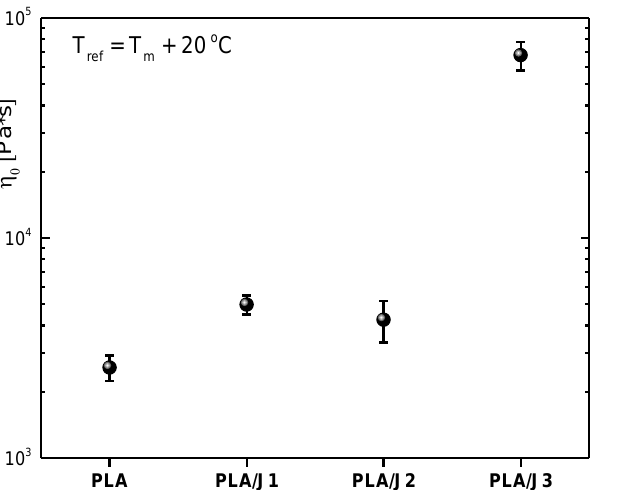
Figure 1. Zero shear (complex) viscosity for all the samples calculated at the same temperature distance from the T m , as derived from the fitting of the data with the Carreau model.